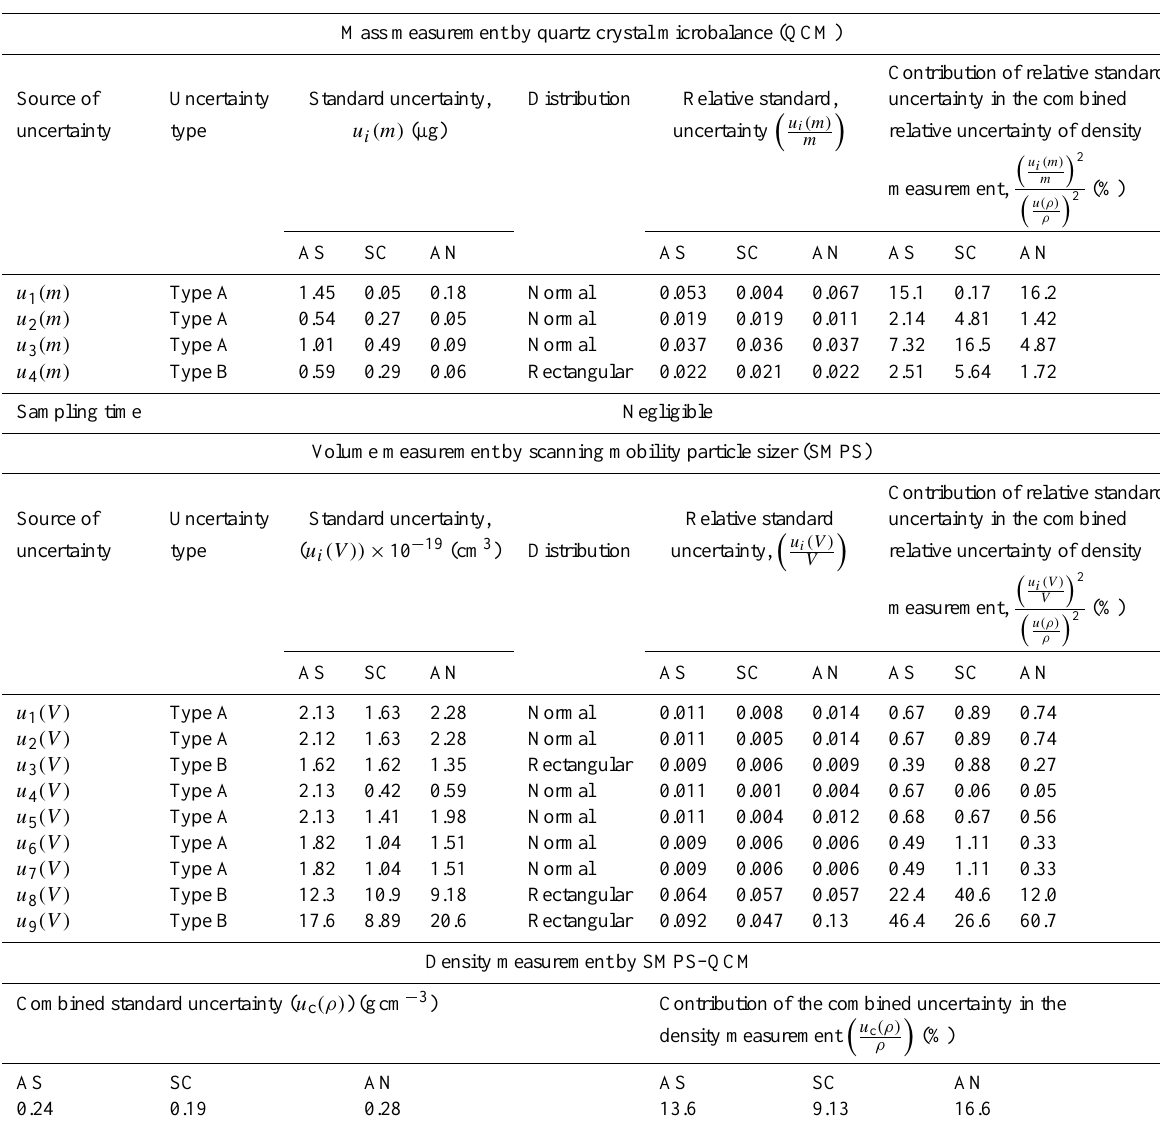
Table 3. The uncertainty budget in the measurement of effective density of laboratory-generated inorganic salt particles (ammonium sulfate, AS; sodium chloride, SC; ammonium nitrate,